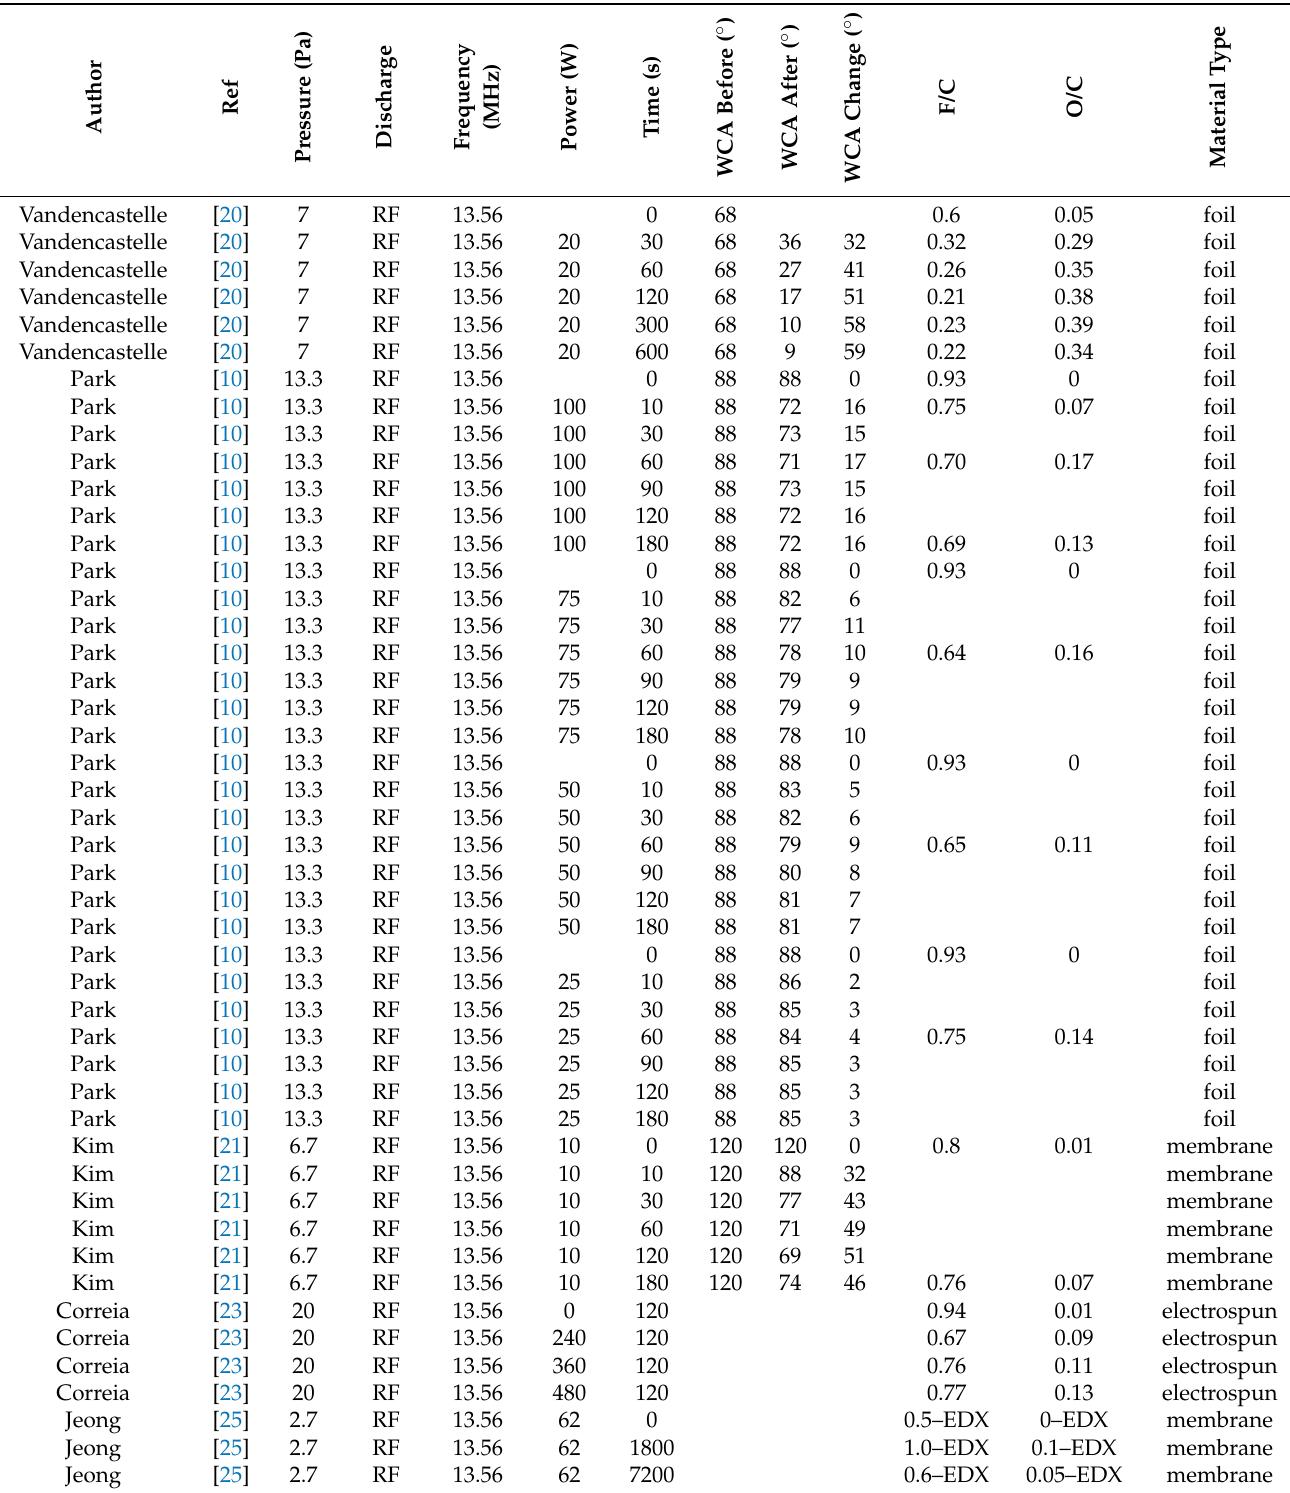
Table 2. Summary of results reported by various authors who have probed oxygen-plasma